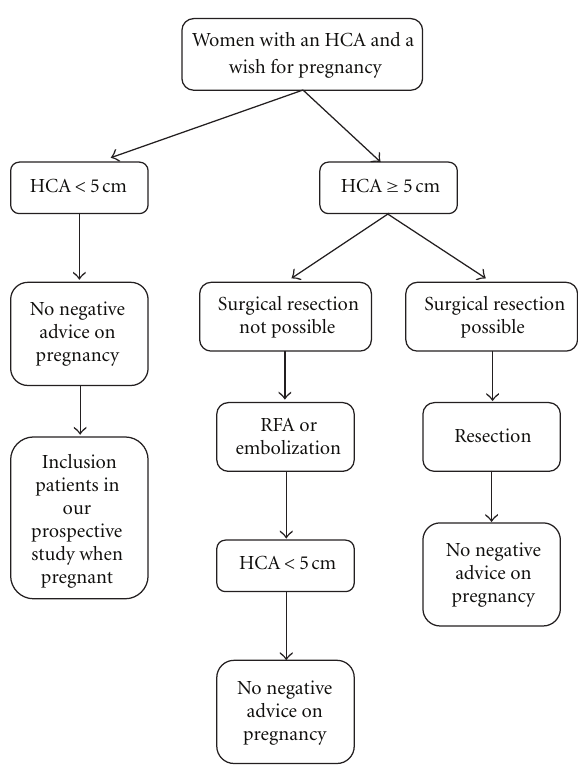
Figure 1: Flowchart for women with a HCA and a wish for